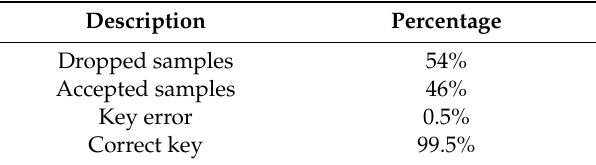
Table 1. Ratios of dropped / accepted sample and key